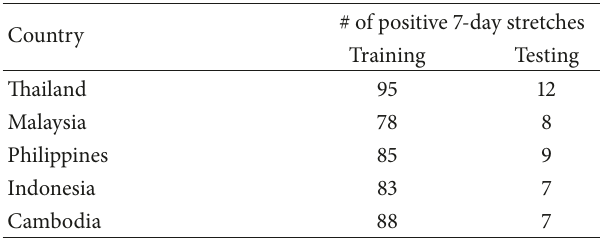
Table 2: Number of positive 7-day stretches in the 778 weeks of our experiment in different